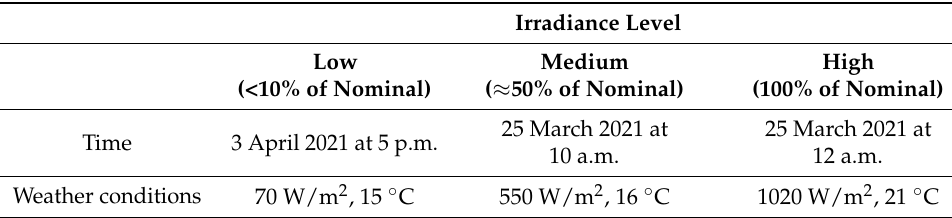
Table 1. Three cases for evaluation of electric power